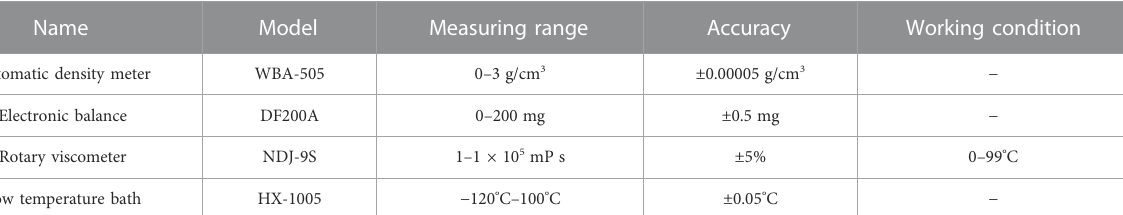
TABLE 1 Main parameters of testing apparatus.